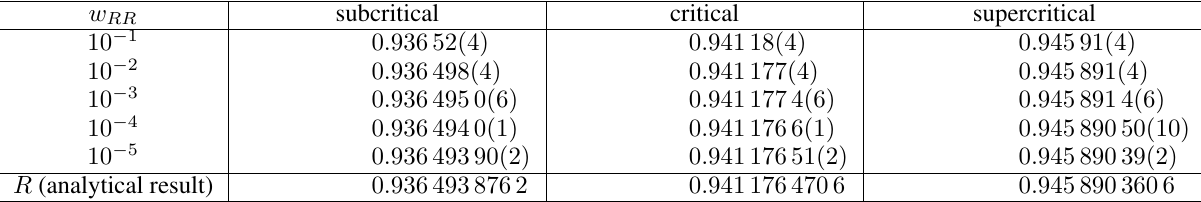
Table 1: Estimated mean and standard error for the total neutron flux integrated over 0 ≤ t ≤ T , for different values of the Russian-roulette threshold w regimes (subcritical, critical and supercritical), with a sample of 10 6 neutrons. w RR subcritical